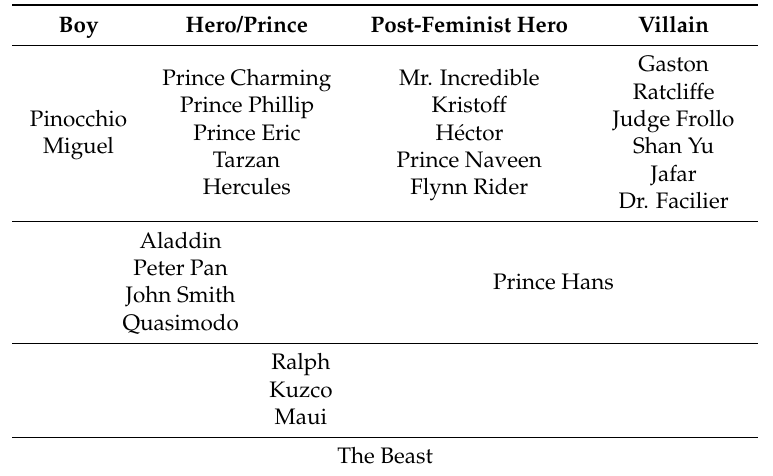
Table 2. Revised Models of Disney